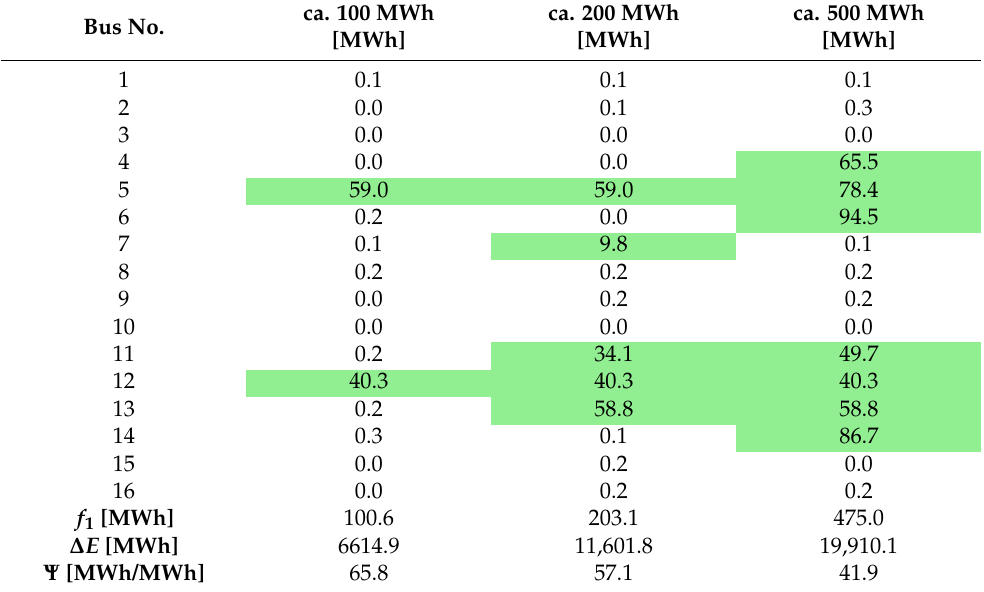
Table 6. Three solutions founded by pa (cid:101) -BRKGA with ca. 100 MWh, 200 MWh and 500 MWh of overall BESS capacity for Test Case 3. Bus No.